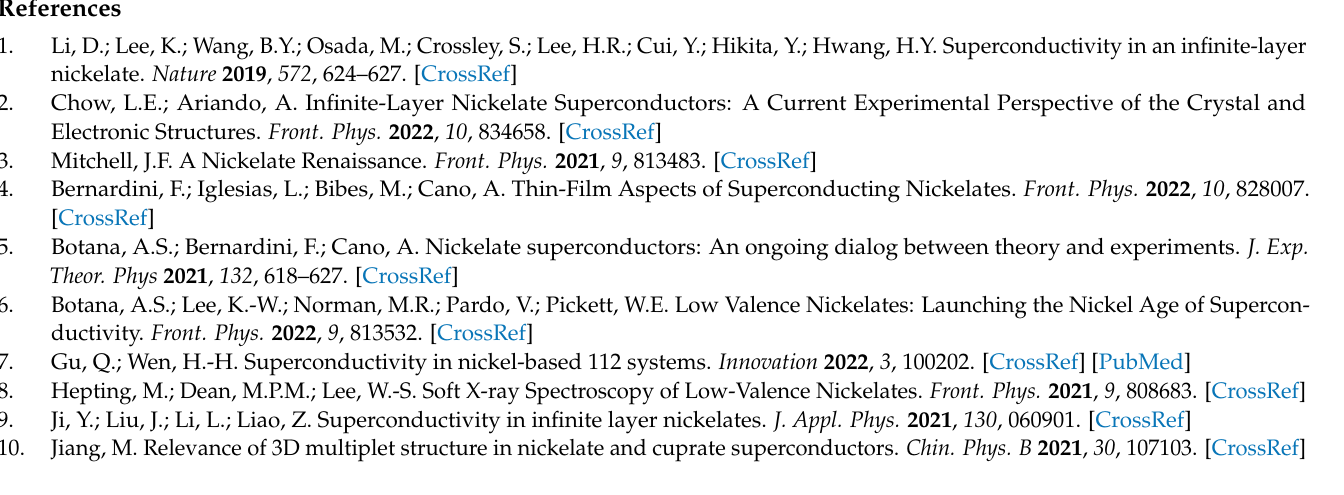
crystals; Figure S2. In-house X-ray powder diffraction for annealed NdNiO 3 sample; Figure S3. (a) Synchrotron X-ray high-resolution powder diffraction pattern for NdNiO 3 at 295 K with Rietveld refinement using the orthorhombic Pbnm symmetry (the purple vertical bar corresponds to the NiO impurity). (b) Synchrotron X-ray high-resolution powder diffraction pattern for NdNiO 3 at 100 K with Rietveld refinement using the monoclinic P 2 1 / n symmetry. (c) Synchrotron X-ray high- resolution powder diffraction pattern for NdNiO 3 at 100 K with Rietveld refinement using the orthorhombic Pbnm symmetry (the inset is observed and calculated powder diffraction intensities around the orthorhombic (044) / (404) pair of reflections); Tables S1–S4. Unit cell parameters and atomic coordinates for NdNiO 3 as obtained from Rietveld refinements to in-house and synchrotron X- ray powder diffraction patterns. The xy data of Figure 7 and Figure S3 are uploaded as Supplementary Materials (in Excel